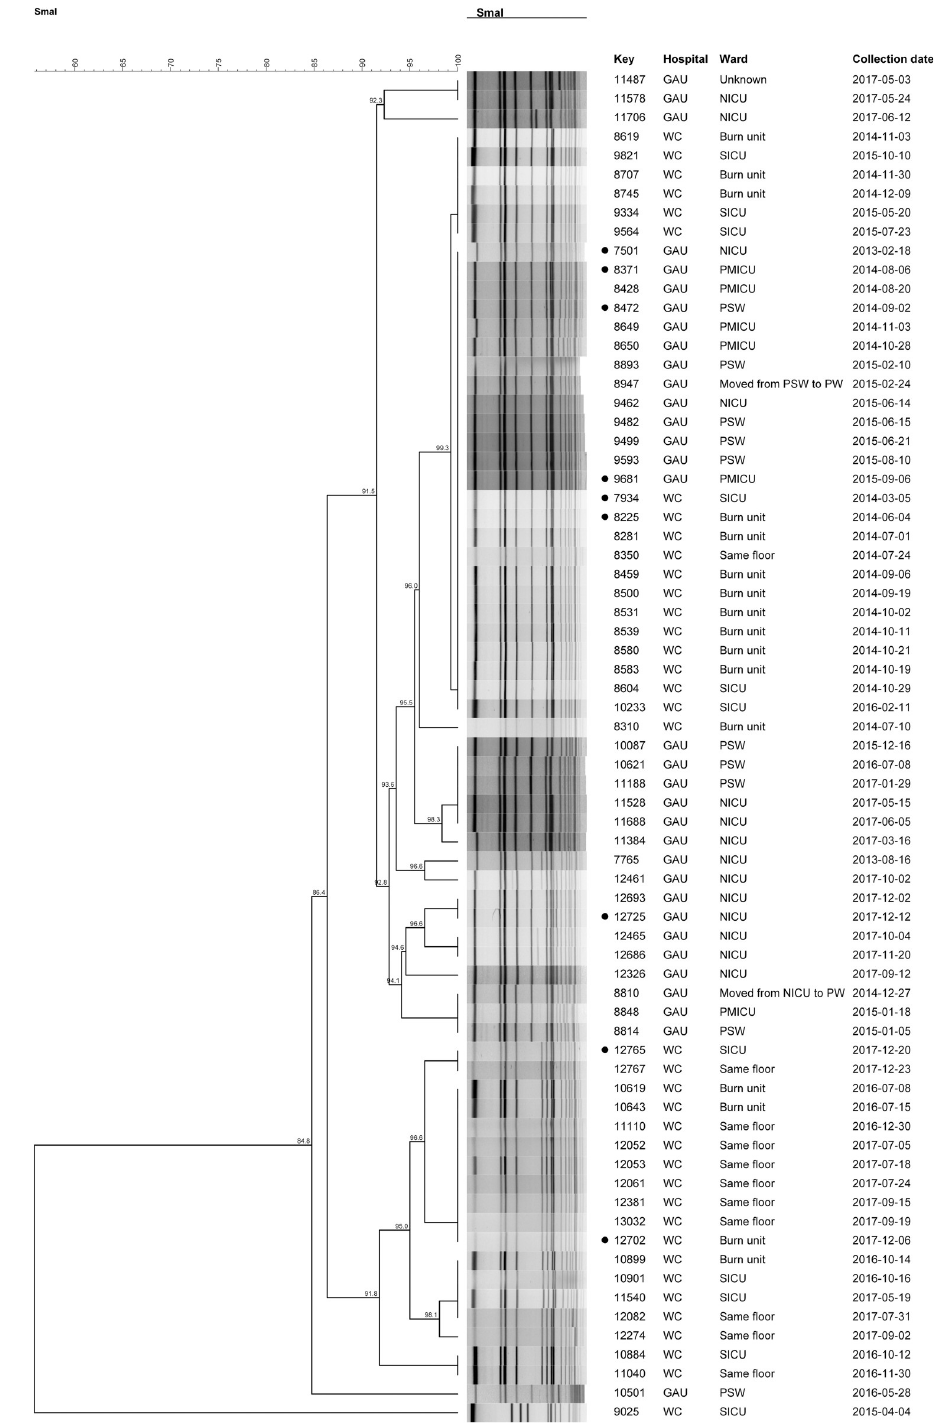
Fig 1. Dendrogram for t037-MRSA cases detected in the Gauteng and the Western Cape hospital. • = Isolates underwent WGS; NICU = Neonatal ICU; SICU = Surgical ICU; PMICU = Paediatric medical ICU; PSW = Paediatric surgery ward; PW = Paediatric ward; WC = Western Cape; GAU = Gauteng.